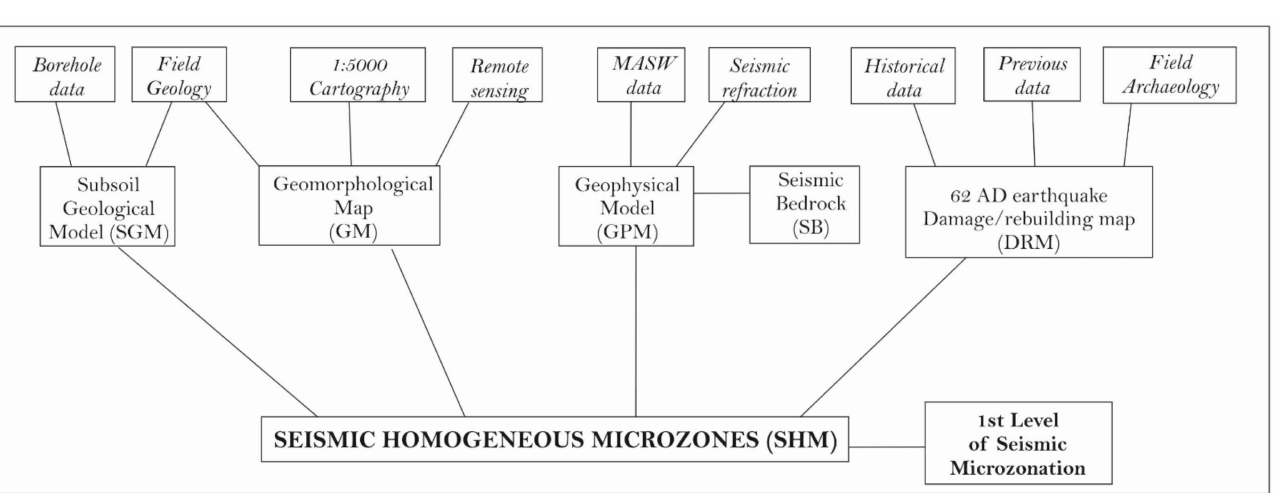
Figure 1. Workflow of the materials and methods and related products used for the drawing of the Pompeii seismic